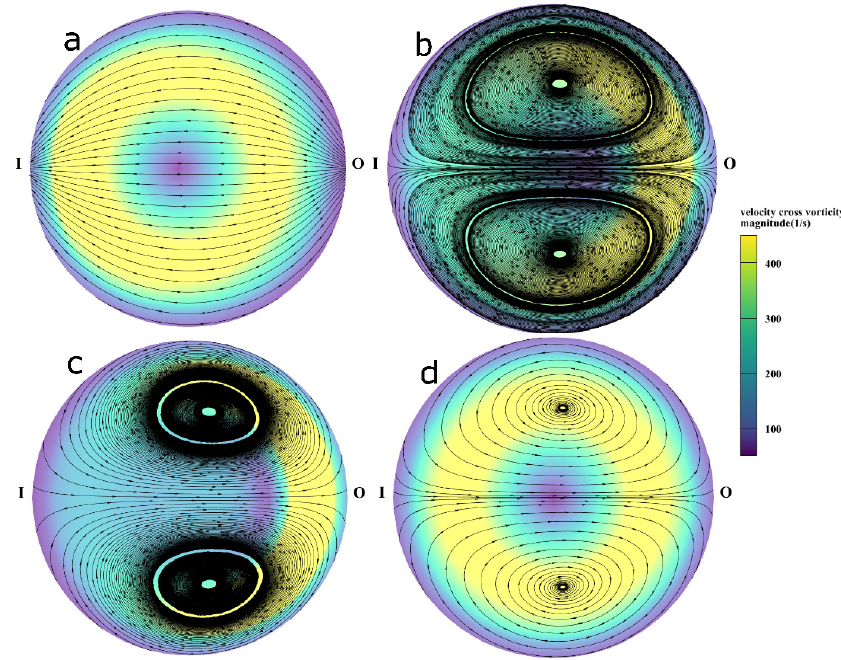
Figure 7. In the 90° channel at the conveying rate of 4.75 cm 3 /s, the profiles of the velocity cross vorticity magnitude and the projected streamlines. The slices ( a – d ) are from the second slice to the fifth slice shown in Figure 2a.